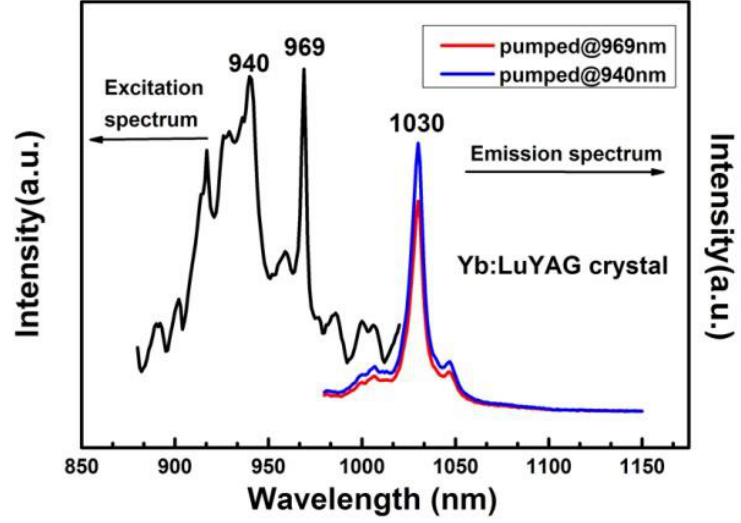
Figure 4. Fluorescence spectrum of Yb:LuYAG crystal.